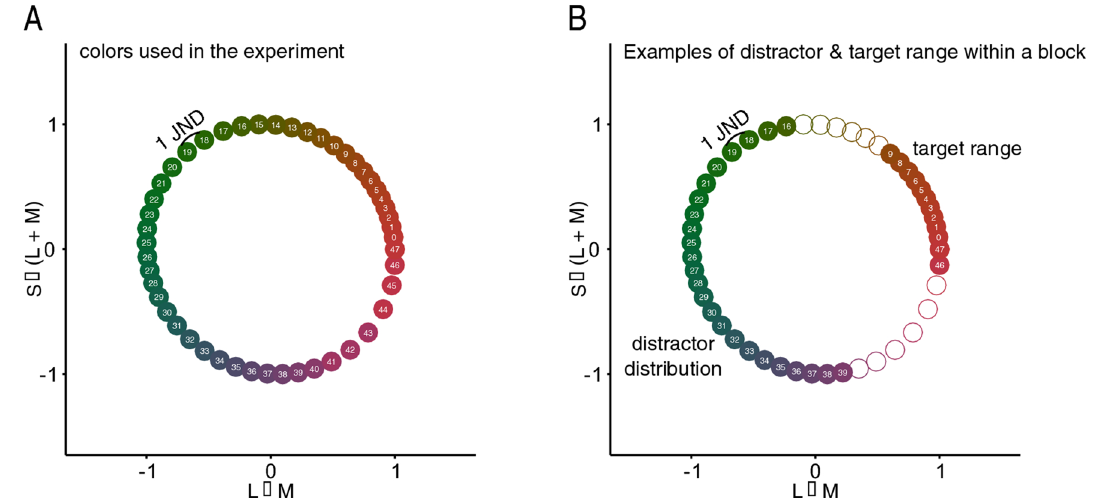
Figure 7. Color wheel with 48 hues used in our study, arranged in DKL space. Neighboring colors are approximately 1 JND apart. The x-axis corresponds to the contrast between L and M cones (L − M), roughly corresponding to the “red-green” dimension. The y-axis corresponds to the variation in S-cone excitation as L + M activation roughly corresponding to the “blue-yellow” dimension. Because of differences in sensory thresholds, colors in some parts of the circle are more distant from each other than in other parts, though differences in JNDs remain the same. ( A ) Full color wheel as used in the study. ( B ) On a particular learning block the distractor distribution and the target color range were constant. Here, the distractor distribution contains a set of greenish colors drawn from a Gaussian distribution with a range of 24 colors. Colors of the targets are obtained from a range that was minimum 18–24 JND away from the mean of the distractor distribution from each side of the distribution. This results in targets being drawn from a range of 12 reddish